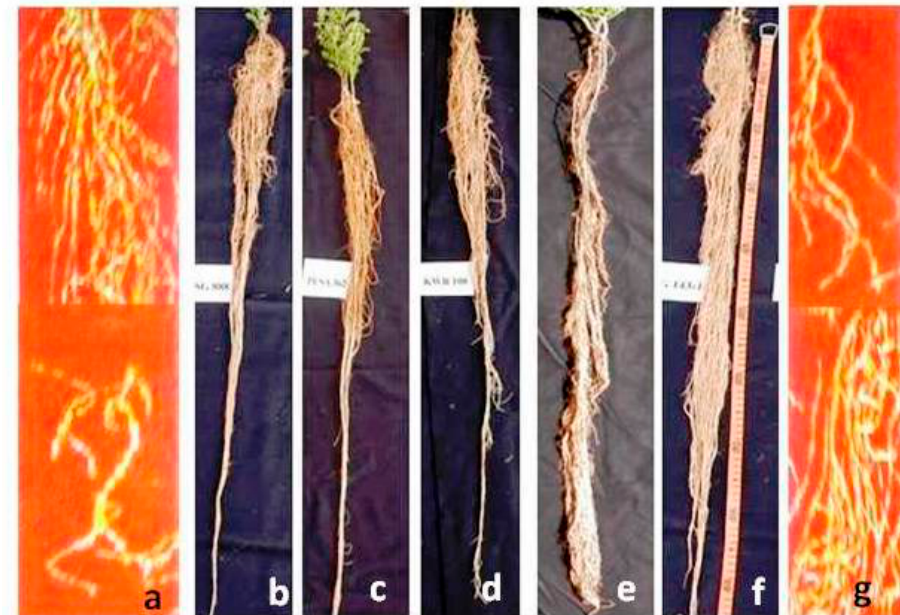
Figure 1. ( a – g ). Root trait phenotyping of chickpea varieties by mini-rhizotron: Scanned root images of five chickpea genotypes viz., RSG 888, Pusa 362, KWR 108, PG 96006 and PG 5. ( b – f ): Root profile of genotypes RSG 888, Pusa 362, KWR 108, PG 96006 and PG 5 at different soil depths and densities when grown in 1.5m long polyvinyl chloride (PVC) tube (20 cm diameter). The tubes were filled with